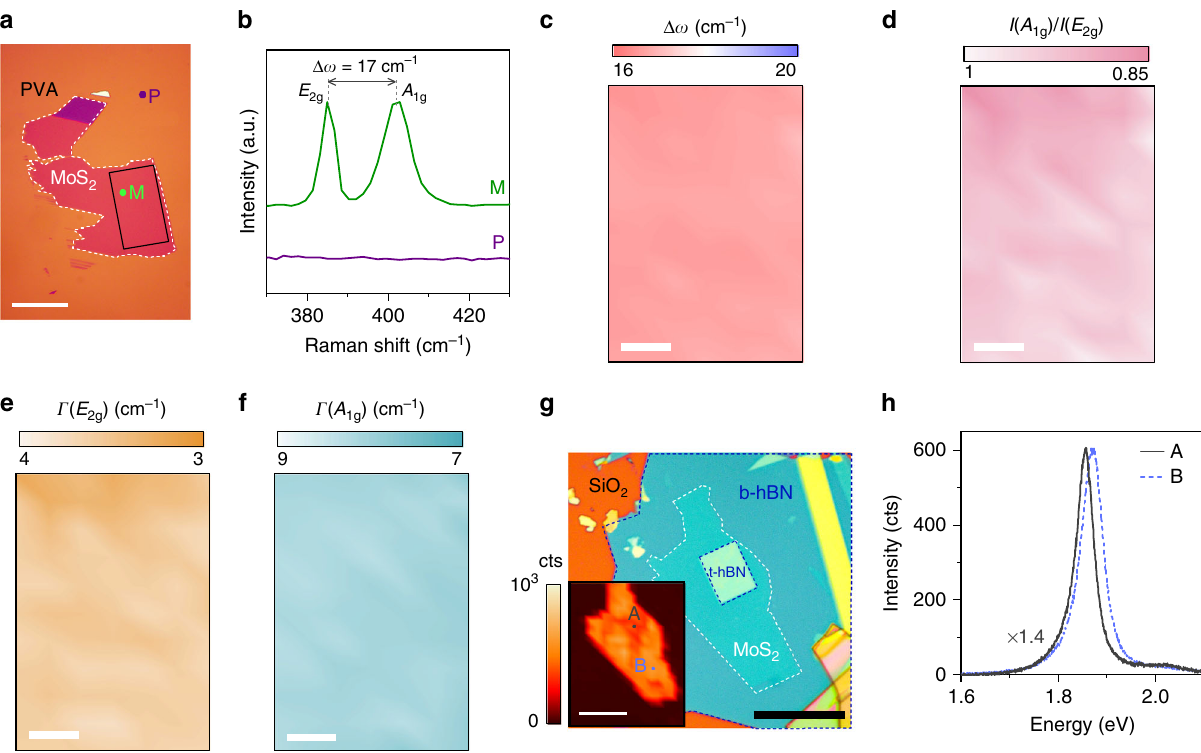
Fig. 6 Fabrication of heterostructures from other layered materials. a Applying PVA- assisted exfoliation technique to MoS 2 consistently yields large monolayer fl akes. Scale bar is 20 μ m. b Corresponding Raman spectra of “ M ” and “ P ” points in a . PVA does not have an overlapping Raman signature with MoS 2 , allowing the use of Raman spectroscopy for identifying the number of layers within the fl ake. c – f The spatial Raman maps of the fl ake in the a indicate the uniformity of its structural properties. The map was taken from the region inside the fl ake marked with the solid black box. In these plots, Δ ω is the spacing between E 2g and A 1g peaks, I ( A 1g )/ I ( E 2g ) is the ratio of the peak intensity, Γ ( E 2g ) and Γ ( A 1g ) are the FWHM of the peaks. Scale bars are 5 μ m. g The optical image of a monolayer MoS 2 encapsulated in hBN. The inset shows the spatial map of the PL peak intensity. Scale bars are 20 μ m. h The representative PL spectra of the monolayer MoS 2 at the encapsulated region (point “ A ” ) and the exposed region (point “ B ” ). The red-shift of the PL spectrum suggests the presence of a small tensile strain within the encapsulated region. The FWHM of the “ A ” and “ B ” spectra are ≈ 46 and 54 meV, indicating the high material quality of the exfoliated MoS 2